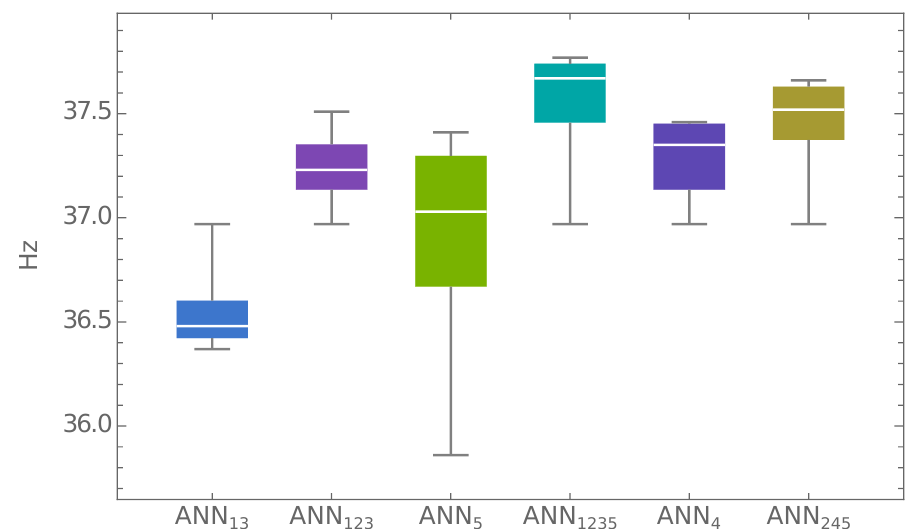
Figure 5. Optimization of f 1 , MODEL1 with three layers of